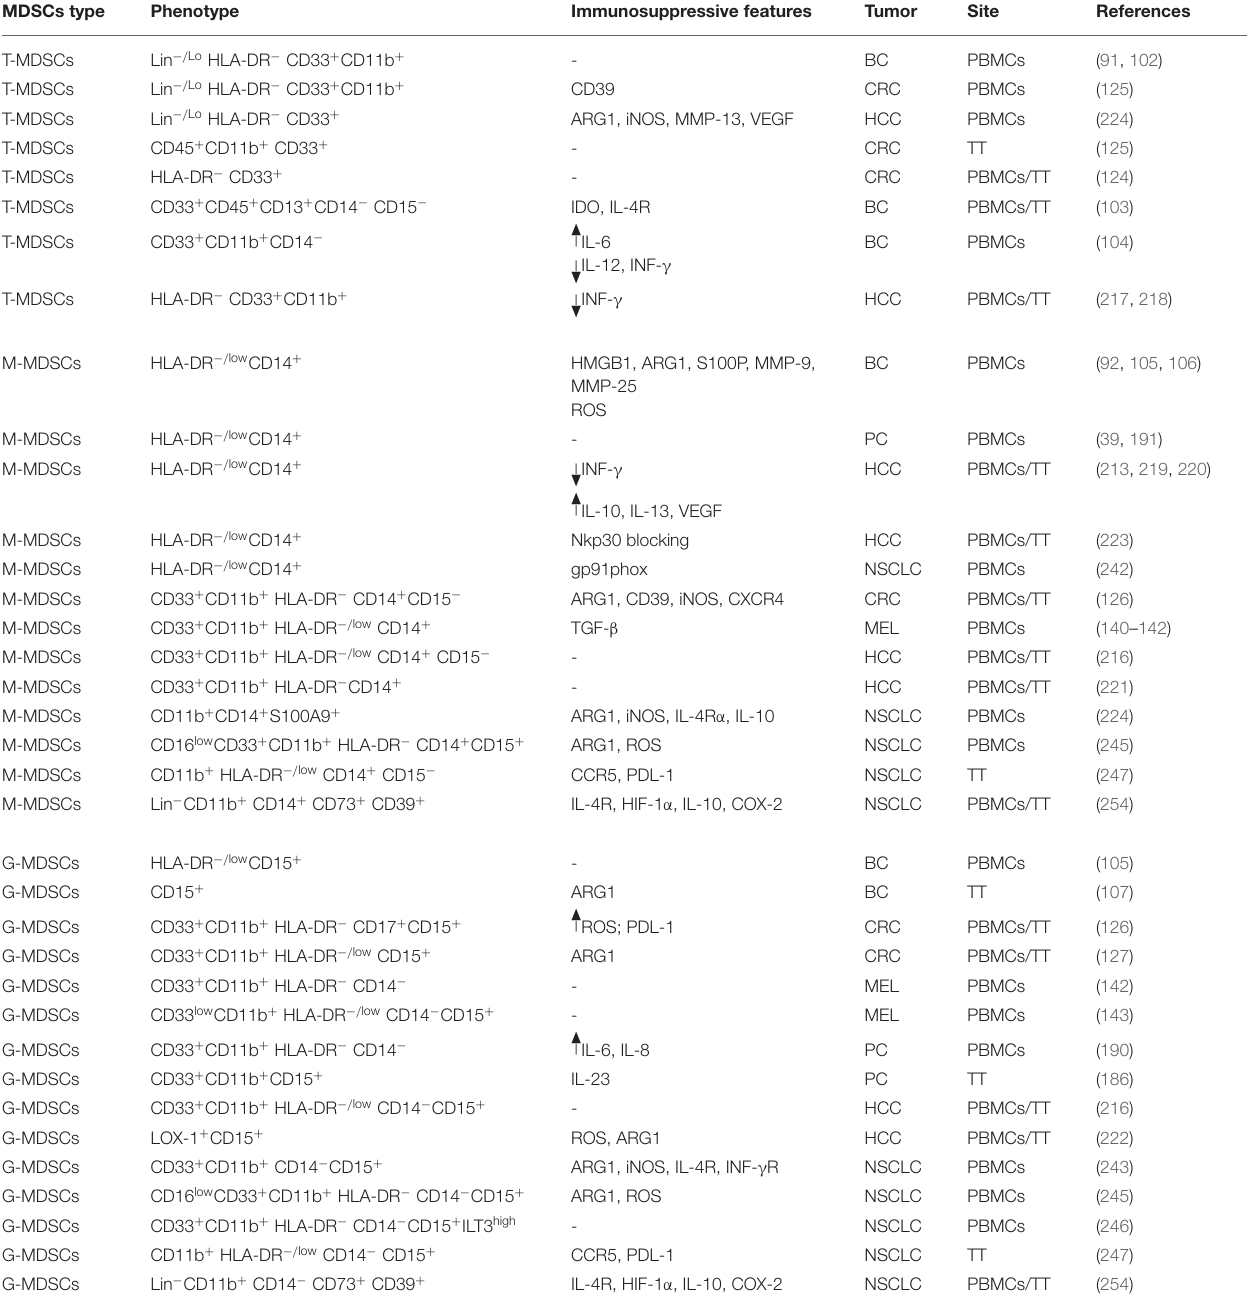
TABLE 1 | Phenotype and immunosuppressive features of MDSCs subsets in cancer